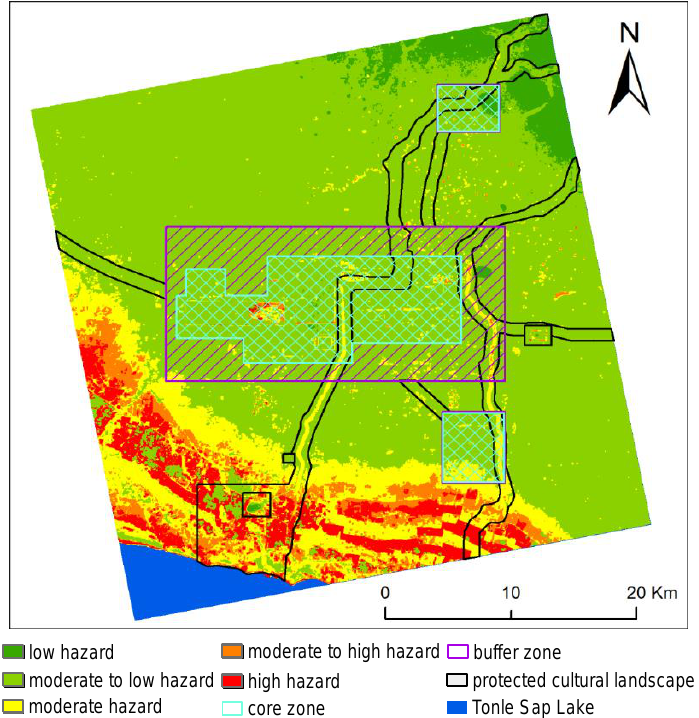
Figure 9. Map showing overlap of core and buffer zones.